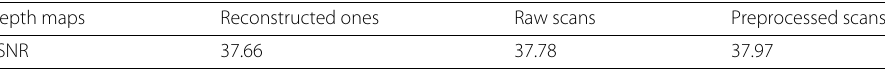
Table 4 Ablation studies for the supervisory depth maps Depth